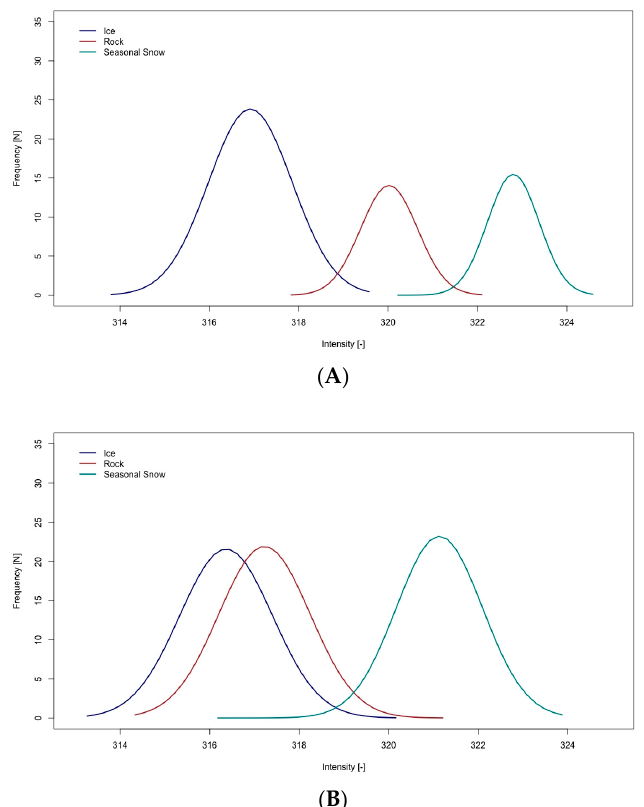
Figure 3. Intensity distribution per surface class from ( A ) 1 August 2014 and ( B ) 4 September 2014. The good separability on 1 August is a result of optimal scan conditions, and the low separability of 4 September 2014 is due to weather conditions.